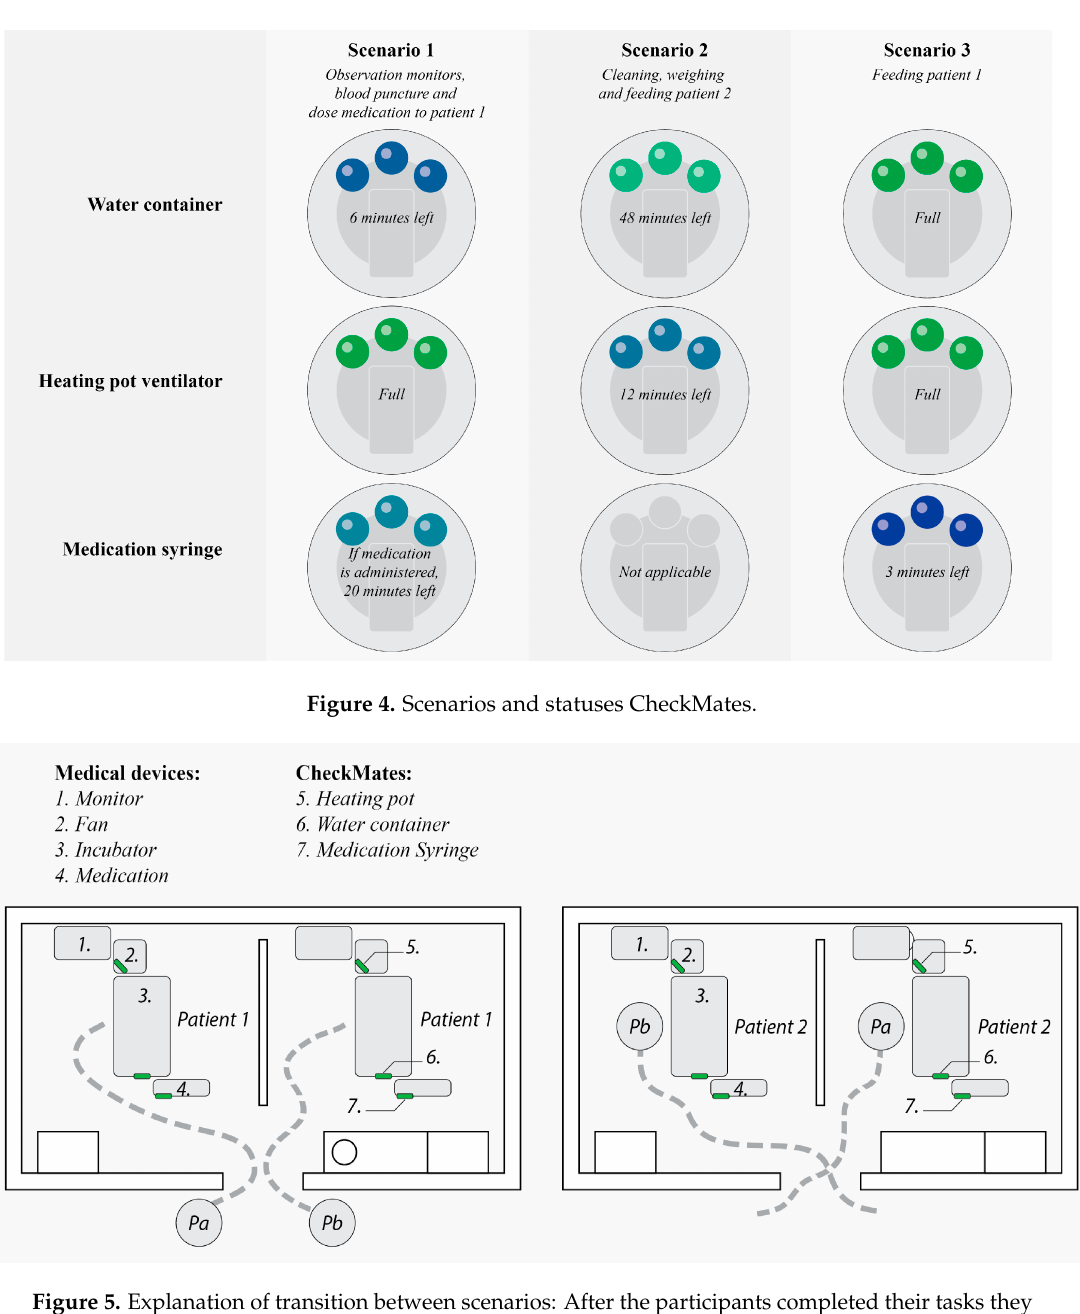
Figure 5. Explanation of transition between scenarios: After the participants completed their tasks they leave the room for a brief moment. They switch places as if they were to take care of another patient when they come in